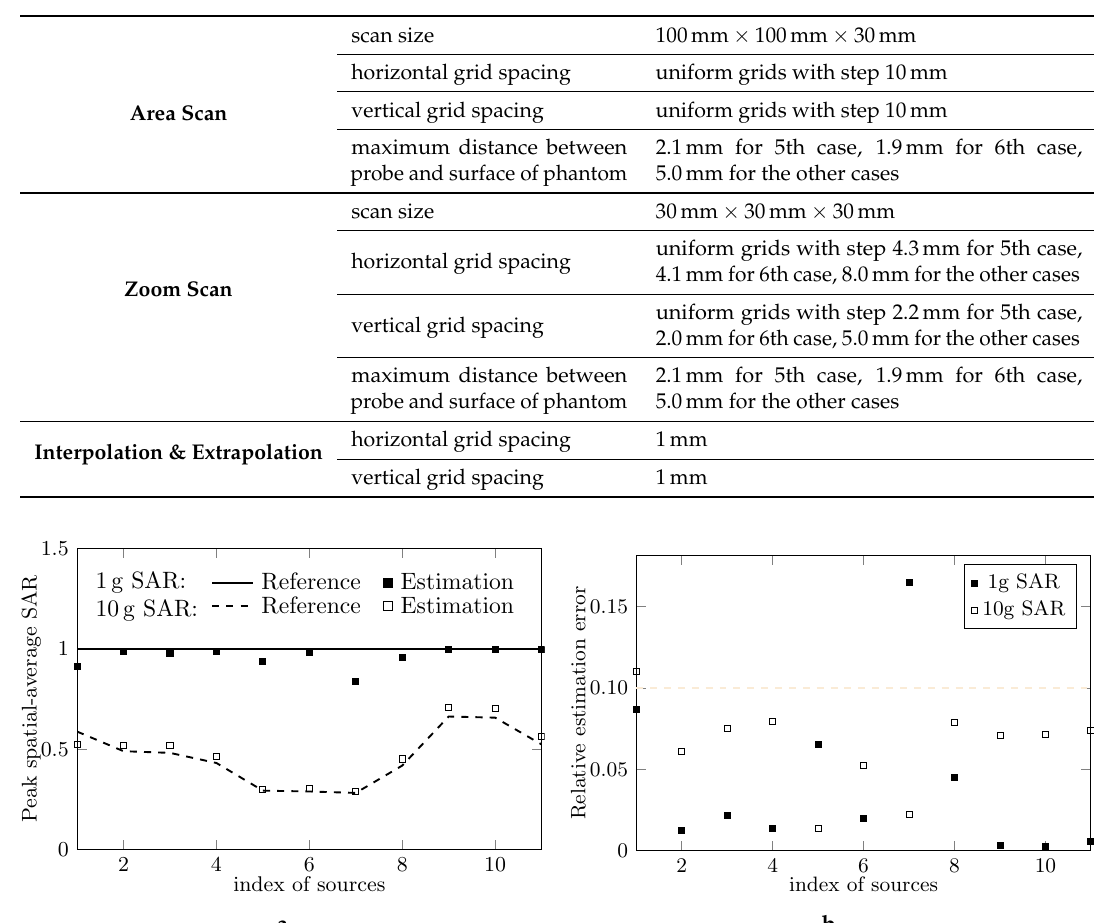
Table 1. Settings for estimations in Figure 1.